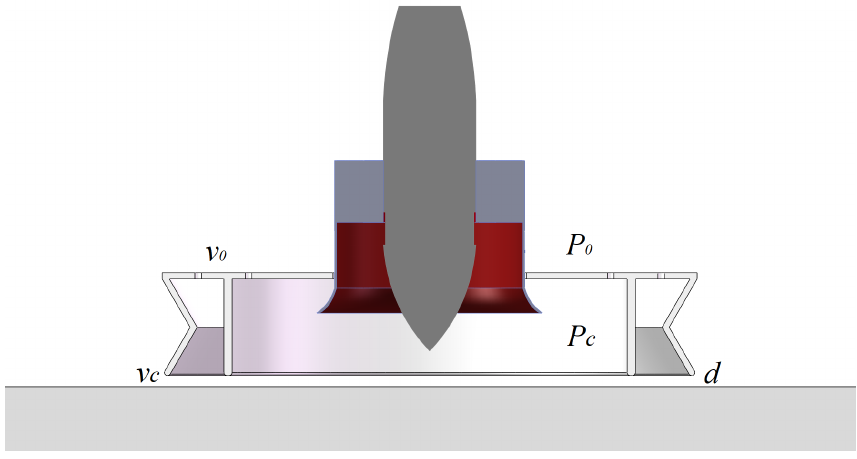
Figure 2. Schematic diagram of the negative pressure air chamber